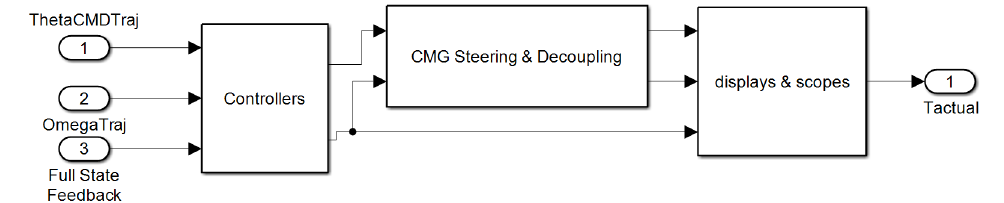
Figure A3. Actuators and Control subsystem in Figure A1.